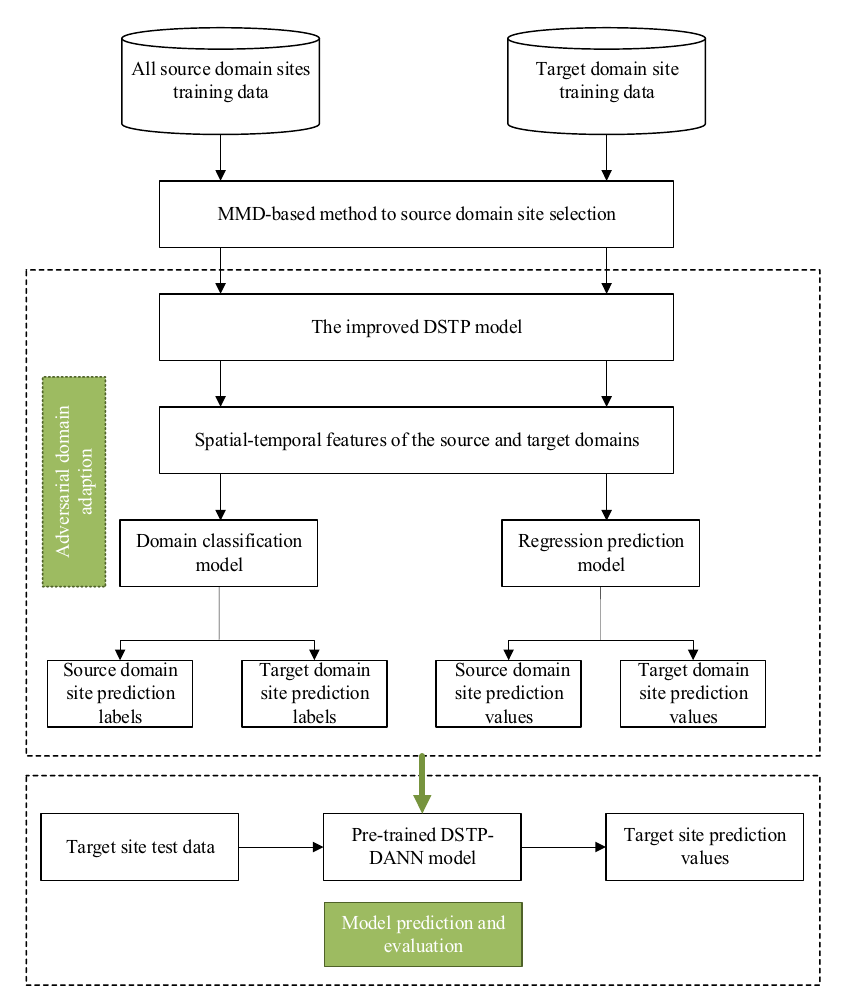
Figure 1. Framework of the proposed